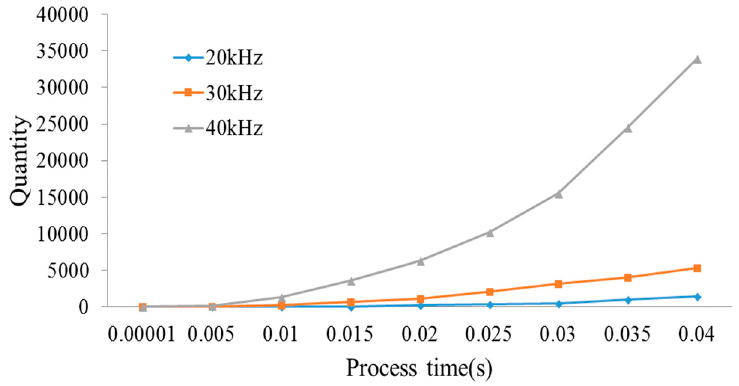
Figure 15. The quantity of debris.